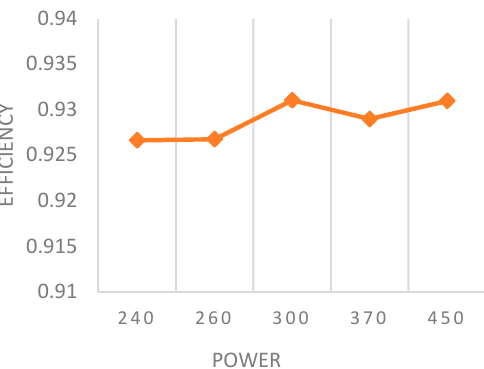
Figure 16. E ffi ciency of the converter at 37 V input and di ff erent loading Figure 16. Efficiency of the converter at 37 V input and different loading points.